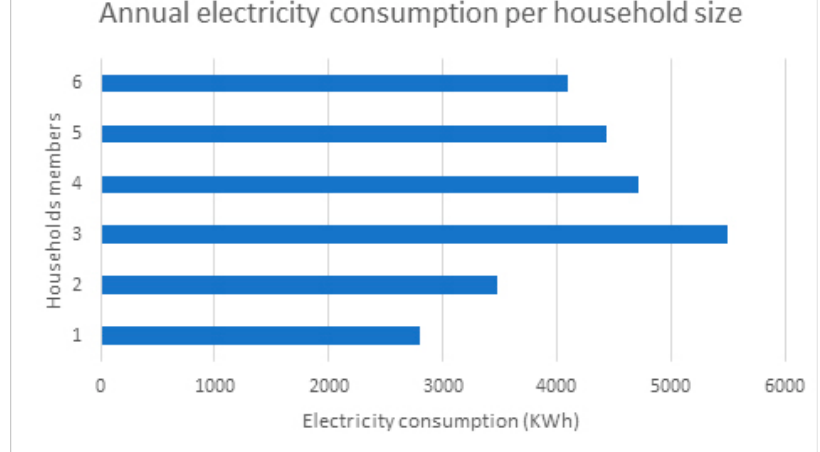
Figure 8. Average annual electricity consumption in relation to household size.